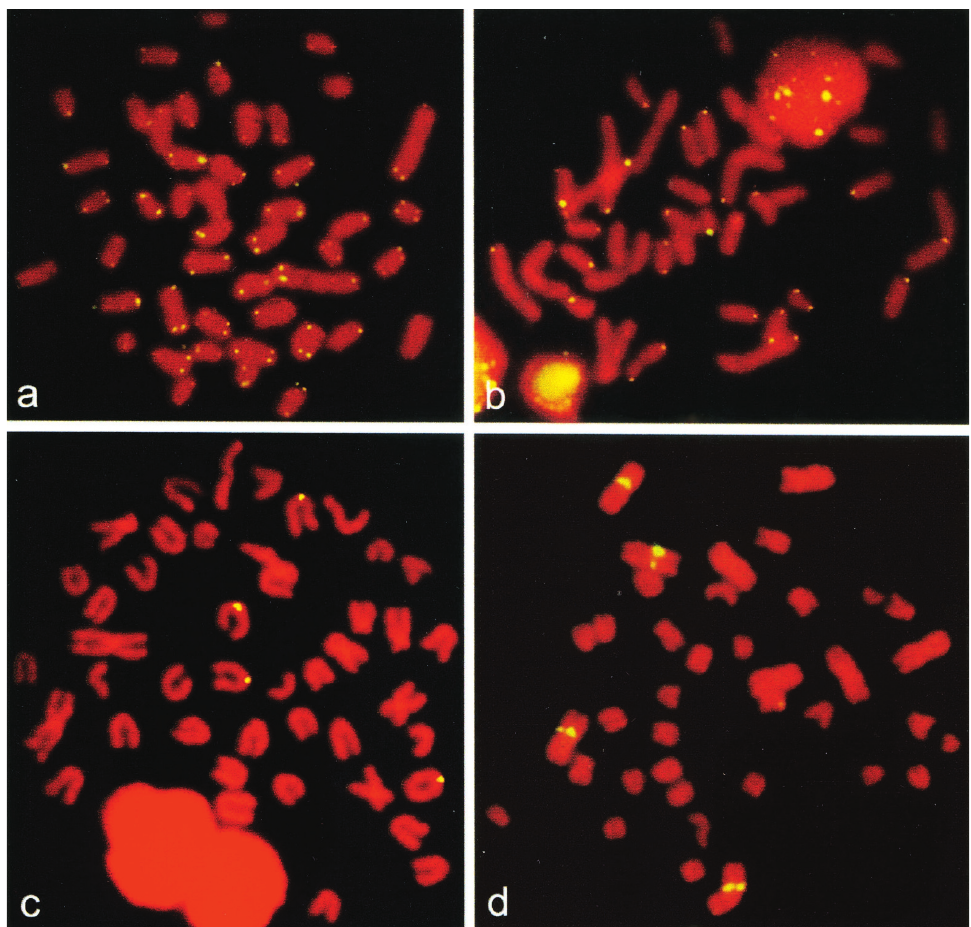
Figure 3 - FISH using a telomeric sequence probe in C. insolata (a) and C. flavicauda (b). The results obtained using a 5S rDNA probe in these same spe- cies are shown in (c) and (d),